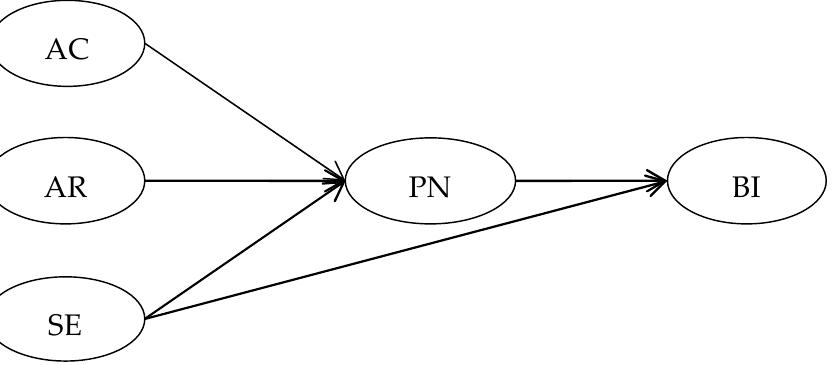
Figure 1. Framework. Note: AC, awareness of consequence of food waste; AR, ascription of responsibility for food waste; PN, personal norm to reduce food waste; SE, self-efficacy; BI, behavior intentions to reduce food waste.